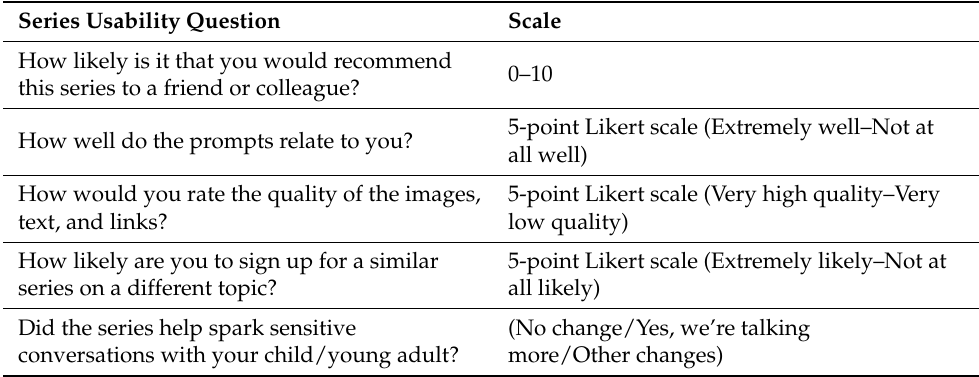
Table 1. Questions for Post-Survey Satisfaction and